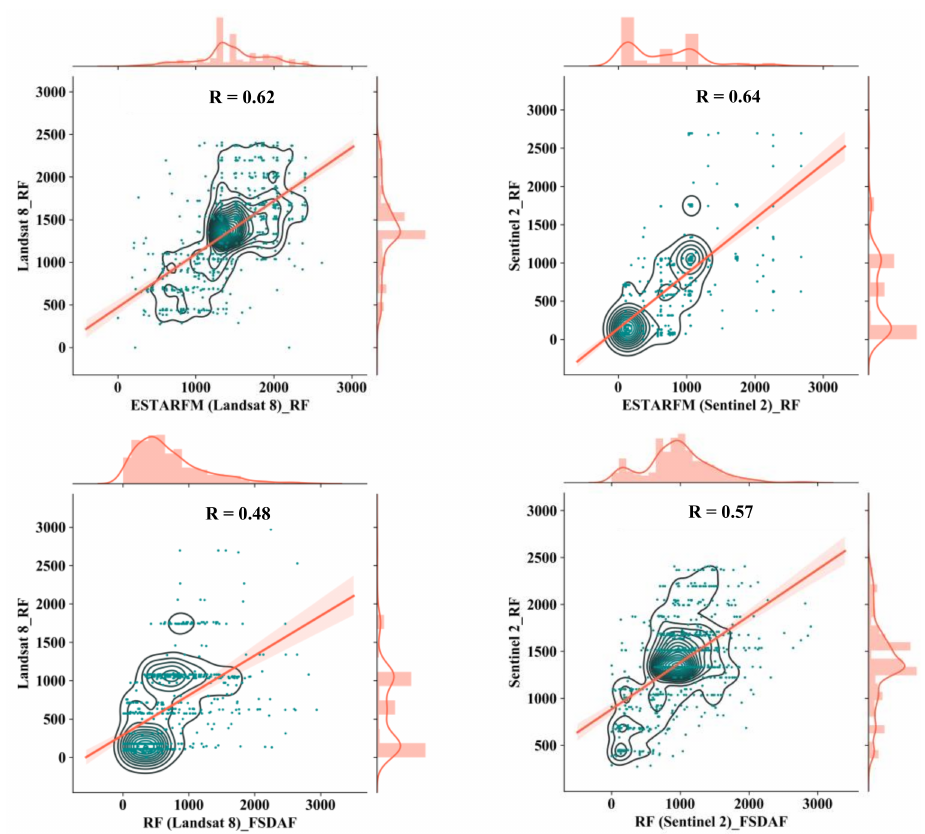
Figure 15. SPM inversion correlation of the original and fused